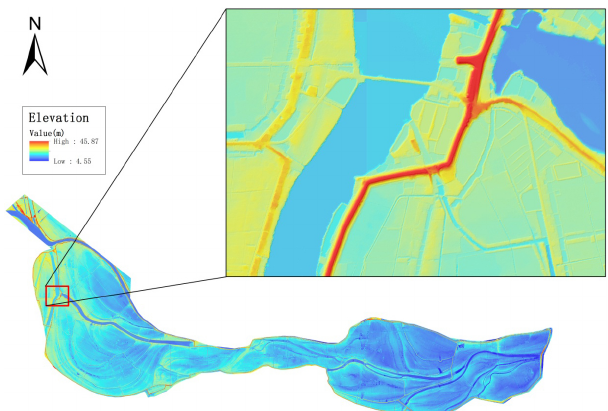
Figure 3. Digital elevation model (DEM) data (1m resolu- tion) for the Gongshuangcha detention basin. Coverage shown is 50km × 20km; Spatial resolution of 1m; DEM grid is 22000 rows × 51000 columns; and file size is